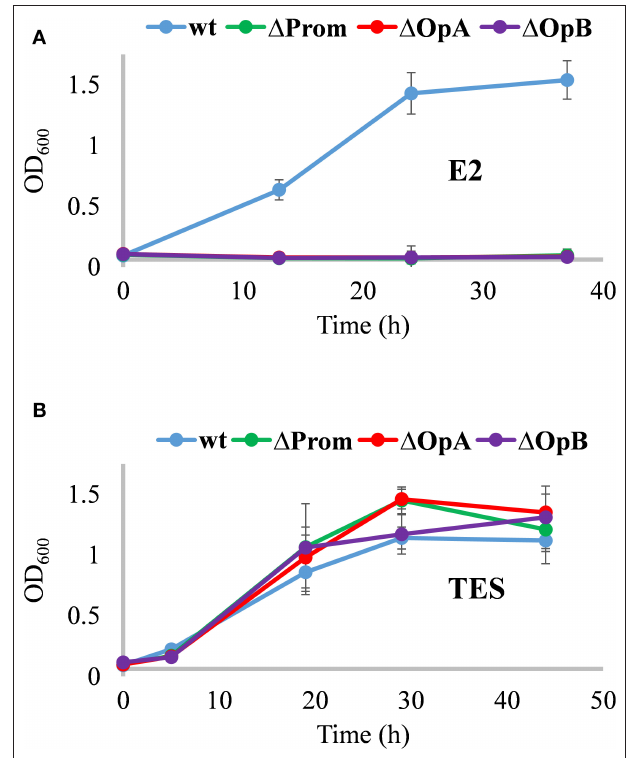
FIGURE 3 | Growth phenotype of N. tardaugens NBRC 16725 (blue), 1 Prom (green), 1 OpA (red), and 1 OpB (purple) strains. Growth curves (OD 600nm) in minimal medium M63 supplemented with (A) 2mM E2 and (B) 1.89mM TES (data corresponding to biological triplicates and error bars show standard